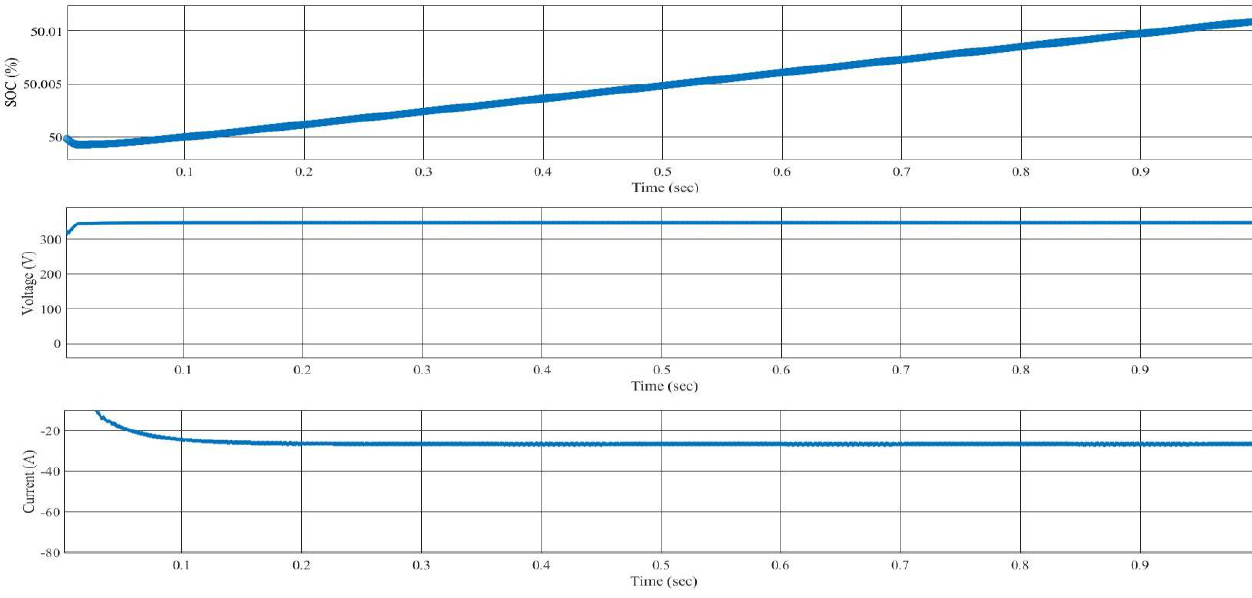
Figure 14 . Charging the EV’s battery from the battery al one.